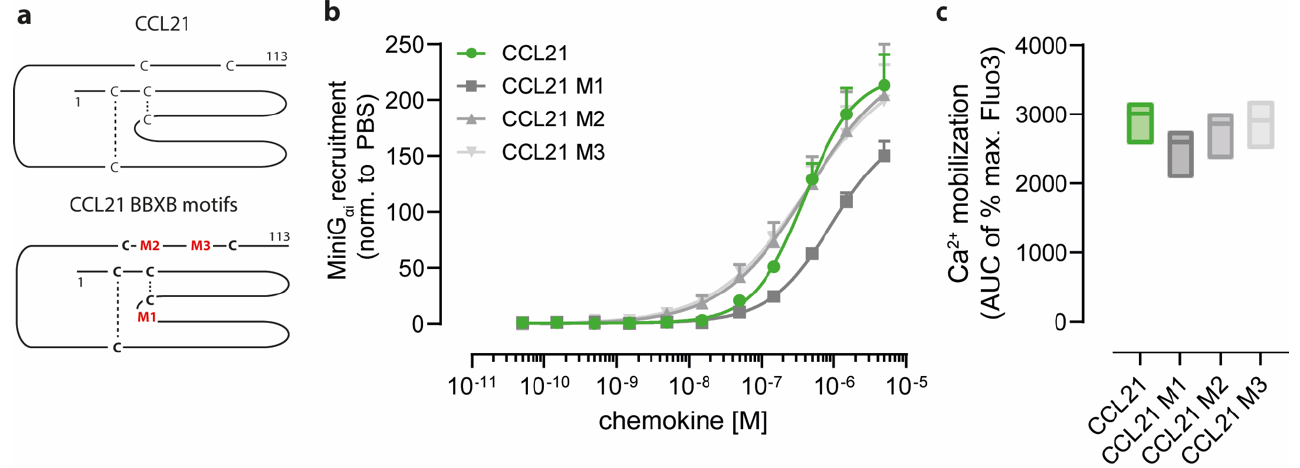
Figure 2. CCL21 variants with individually mutated BBXB motifs remain functional. ( a ) Scheme of CCL21 where the three BBXB motifs are marked in red with M1, M2 and M3. ( b ) Recruitment of lgBit-MiniG α i to CCR7 upon stimulation with graded concentrations of either native CCL21 or its BBXB motif mutants. Normalized mean AUC values ± SD of n = 3 for each chemokine variant are shown. ( c ) Intracellular Ca 2+ mobilization of 300-19 pre-B cells expressing CCR7 upon stimulation with 50 nM of the indicated CCL21 variant. Median AUC values from min. to max. of three independent experiments that were normalized to the maximal fluorescence induced by ionomycin are